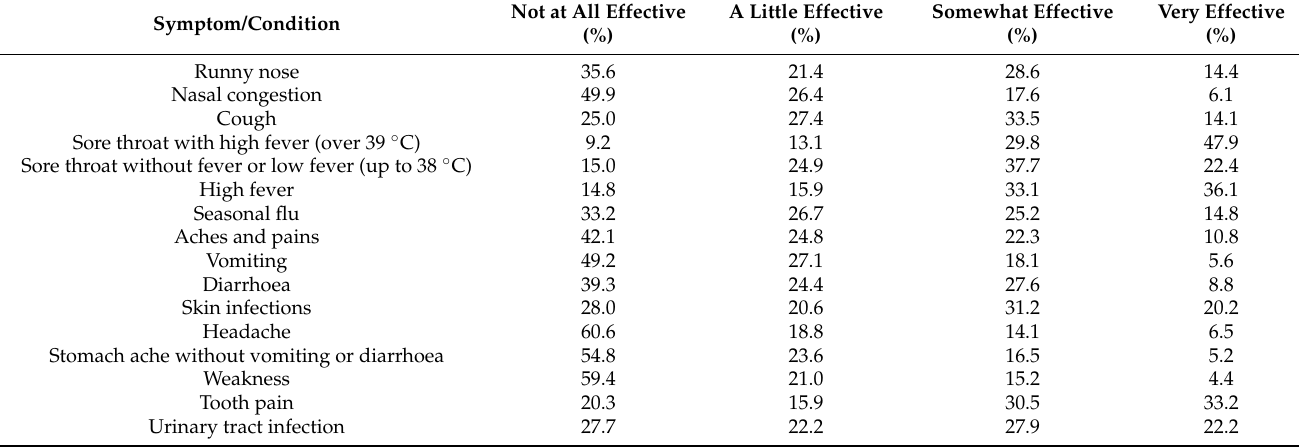
Table 2. Beliefs about the effectiveness of antibiotics: distribution of answers.